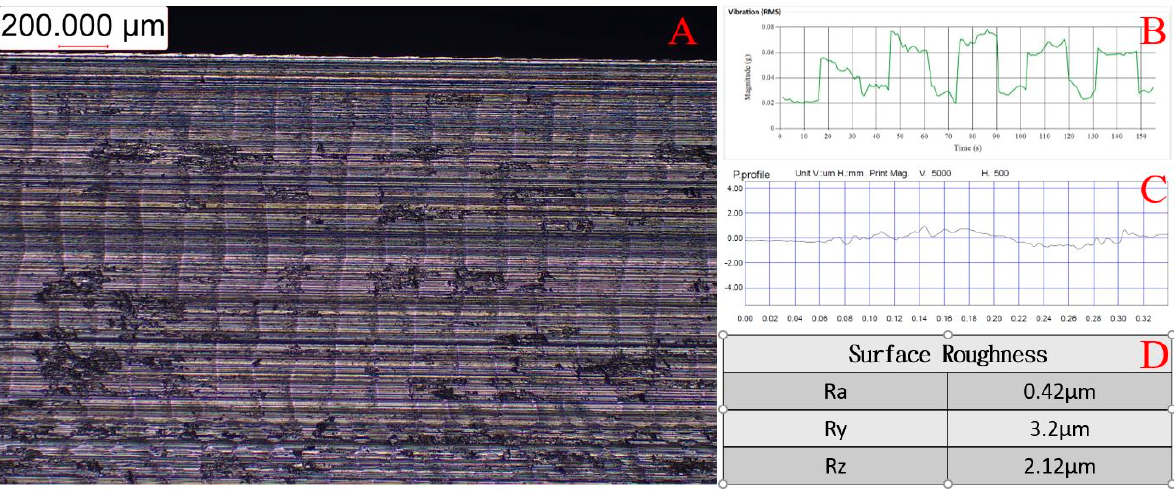
Figure 21. D5 measurement result of Parameter 3.